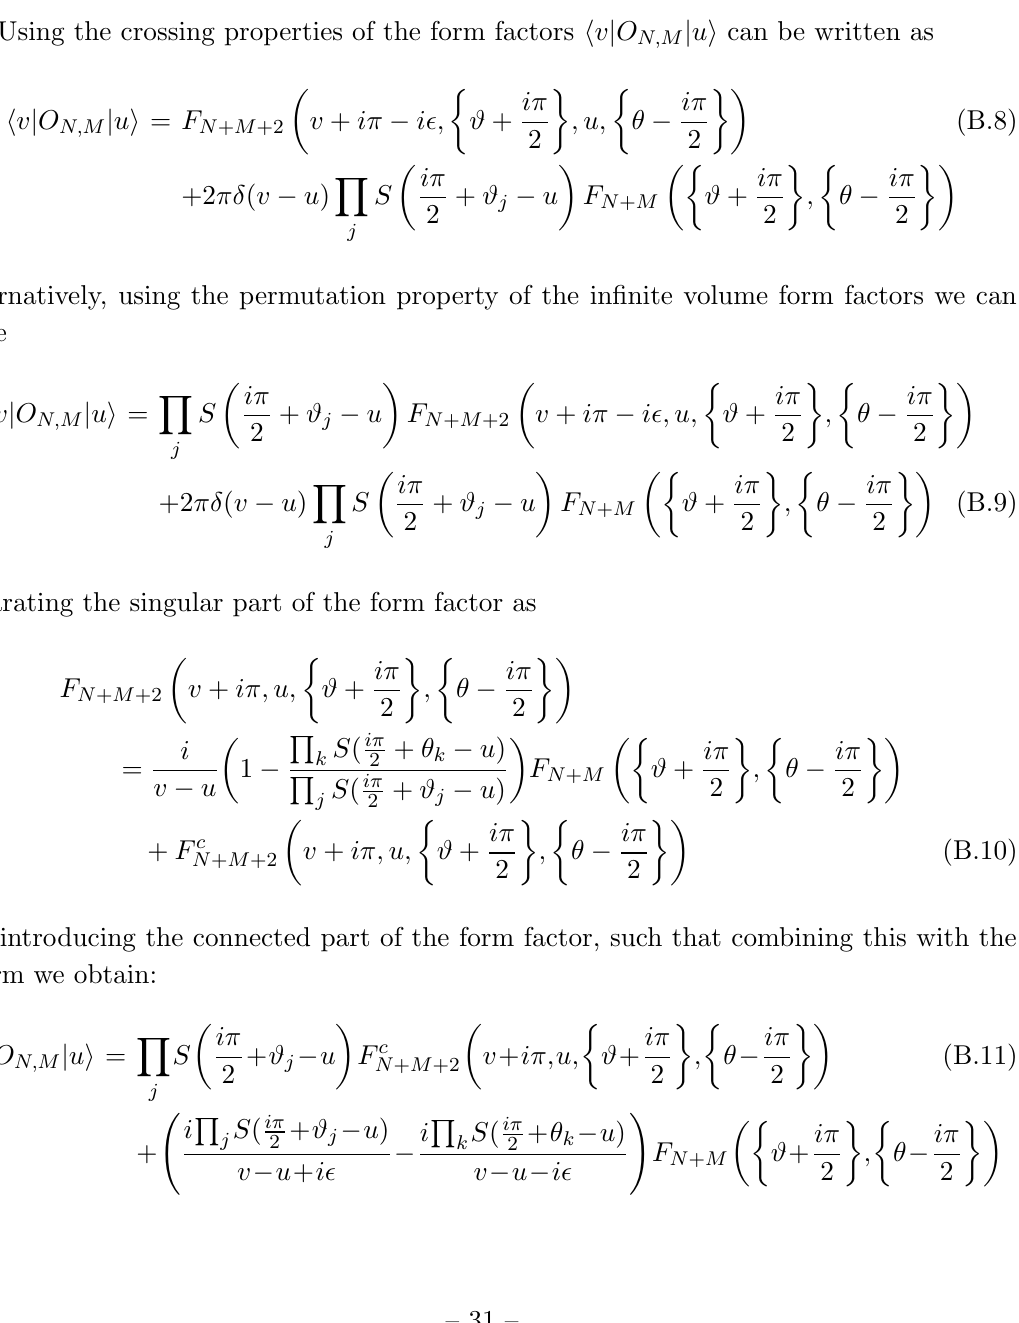
Figure 16 . Graphical representation of the matrix element of the non-local operator